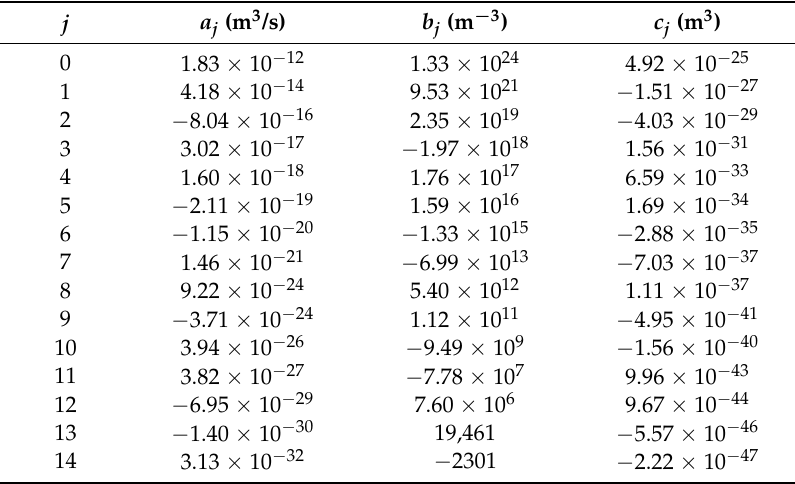
Figure 1. Gain spectra of an 800-nm semiconductor laser calculated using Equations (3) and (6) when the carrier density is varied from 1.25 × 10 24 m − 3 to 2.00 × 10 24 m − 3 in 0.05 × 10 24 m − 3 steps. Table 1. Coefficients of parameters in Equation (6).